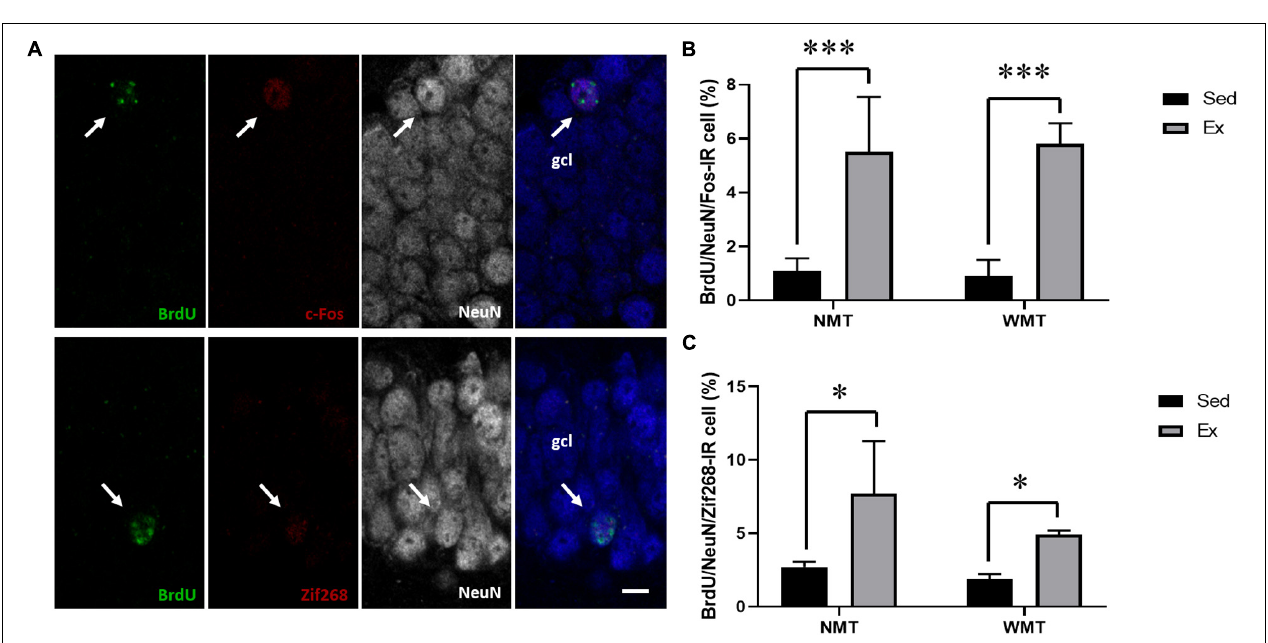
FIGURE 9 | Spatial memory induces activation of IEGs in adult-born neurons. (A) Representative images of adult-born neurons activated during the probe test of reversal learning. The fourth column is the merged image. Arrows indicate the respective labeling; scale bar, 10 µ m. (B,C) Percentage of adult-born neurons expressing c-Fos or Zif268 in the granular cell layer (gcl) of the hippocampal dentate gyrus. Ex indicates exercise; NMT, mice with no memory traces; WMT, mice with memory traces; and Sed, sedentary. Data are graphed as means ± SEM ( n = 3–4). Data analysis used two-way ANOVA. ∗ p < 0.05, ∗∗∗ p < 0.001.